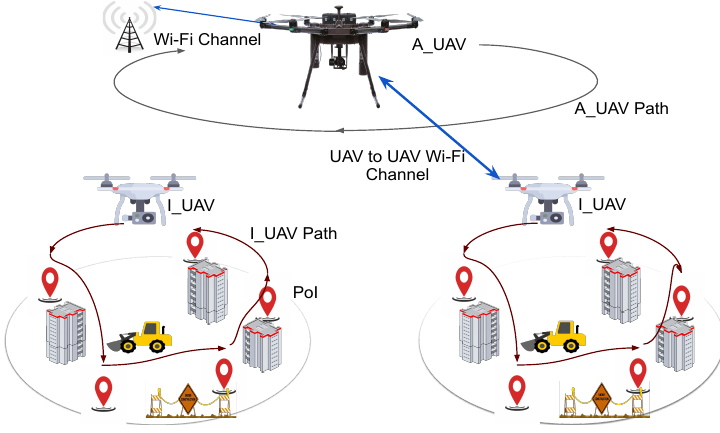
Figure 1. System